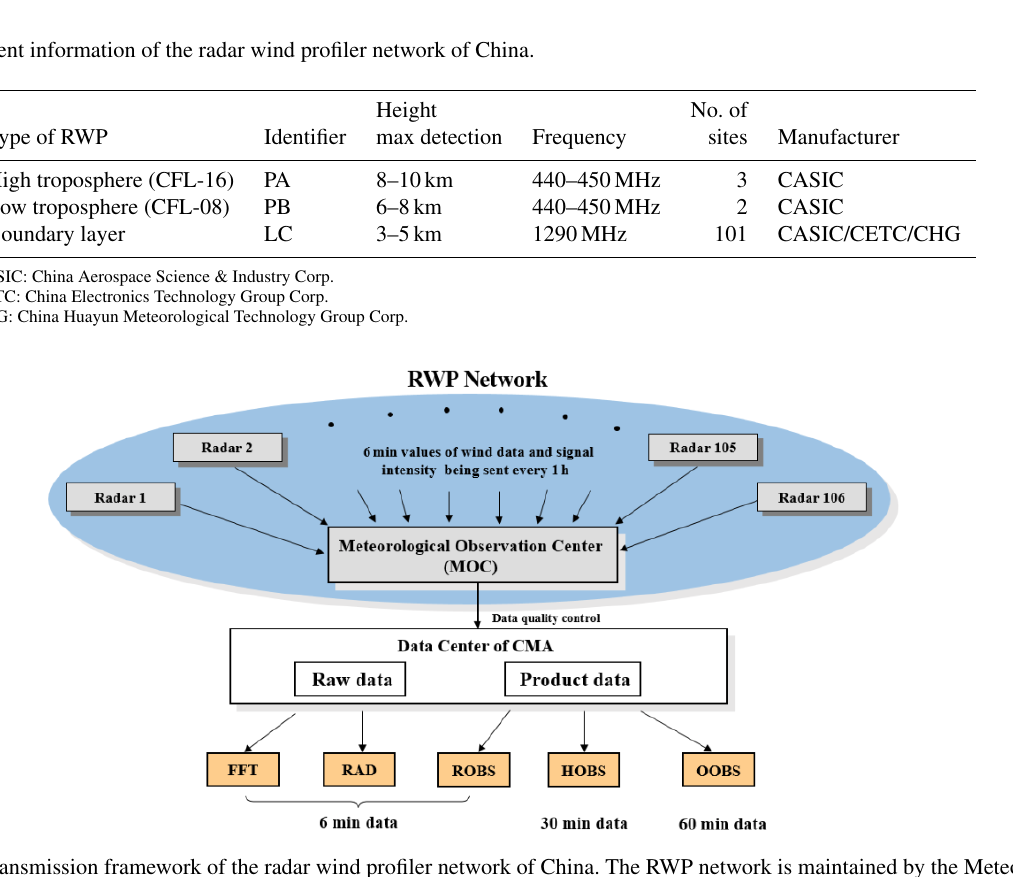
Figure 2. Data transmission framework of the radar wind profiler network of China. The RWP network is maintained by the Meteorological Observation Center (MOC), China Meteorological Administration